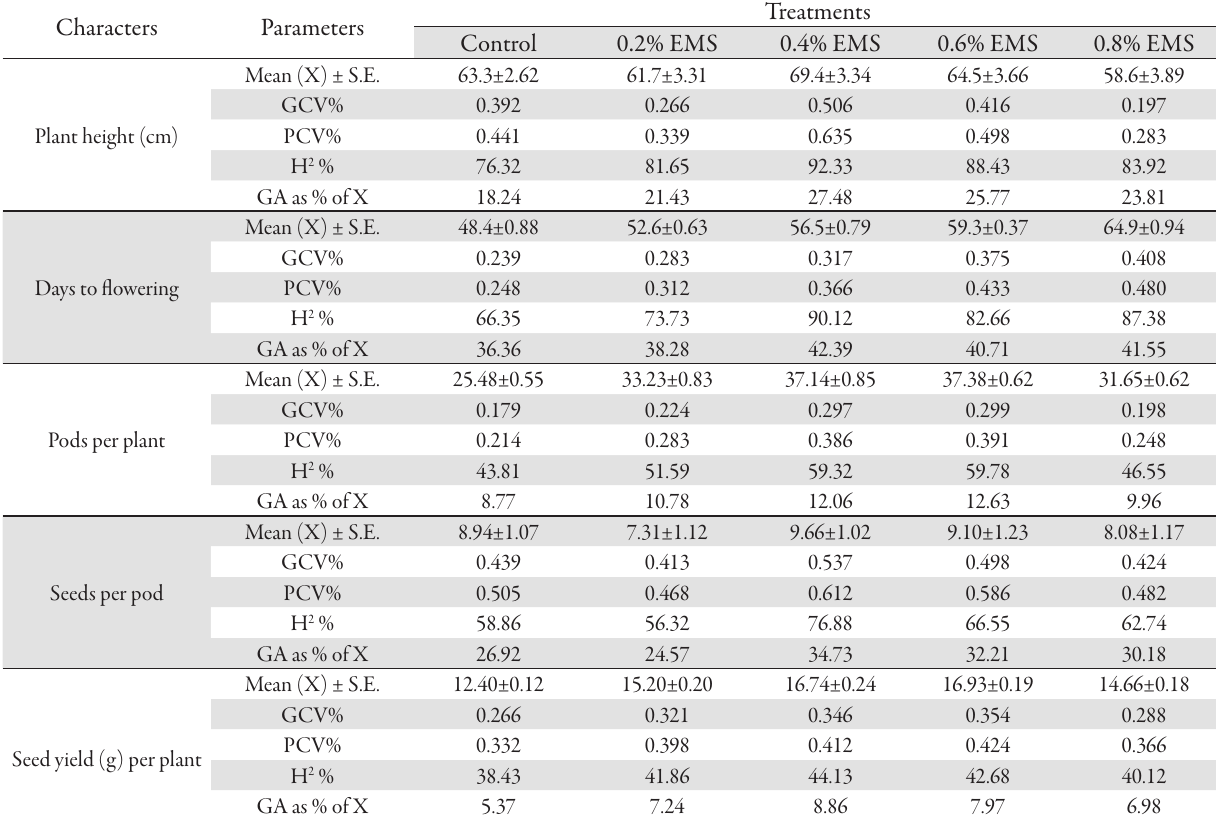
Tab. 5. Different genetic parameters viz . genotypic and phenotypic coefficient of variation (GCV and PCV), heritability (H 2 ) and genetic advance (GA) as percent of mean of five prime agro-metrical traits for EMS treated mungbean